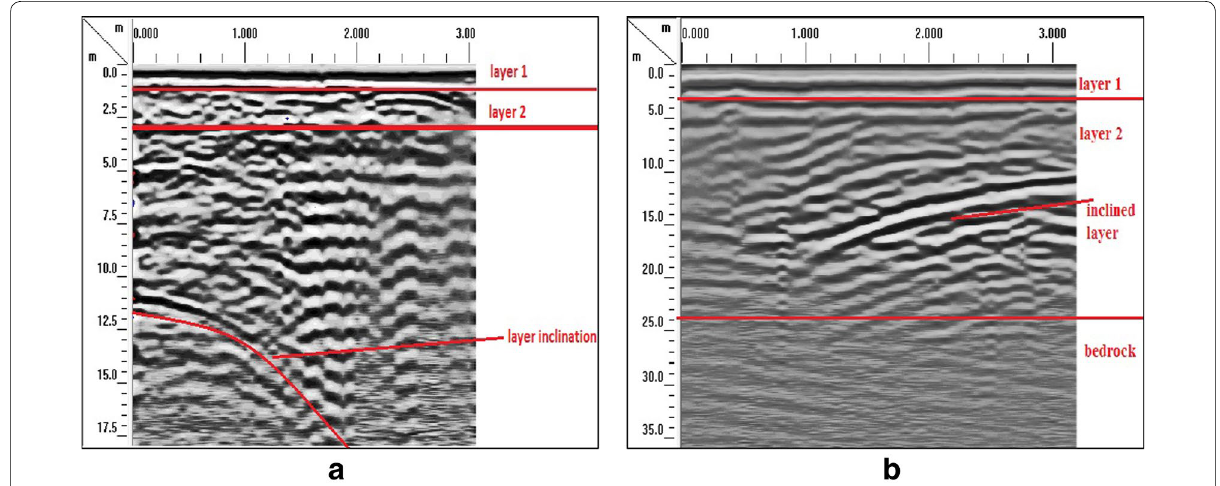
Fig. 5 GPR results at Santura Devi temple area, Mussoorie with a 80 MHz and b 35 MHz